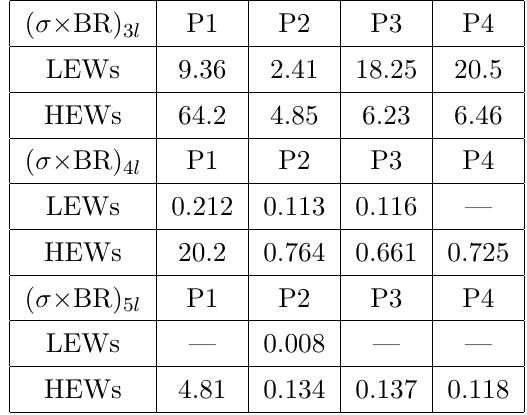
Table 3 . E(cid:11)ective cross-sections, namely (cid:27) (cid:2) BR, for three di(cid:11)erent signals | 3 l , 4 l and 5 l for four representative points in table 1. See text for the details. Cross-sections are in fb